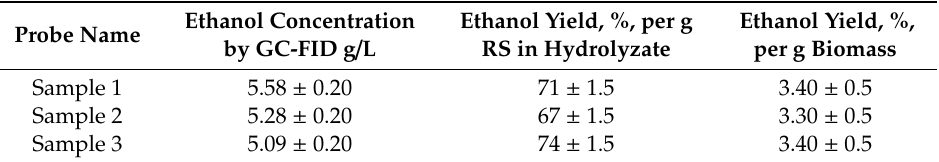
Table 6. Ethanol yields after